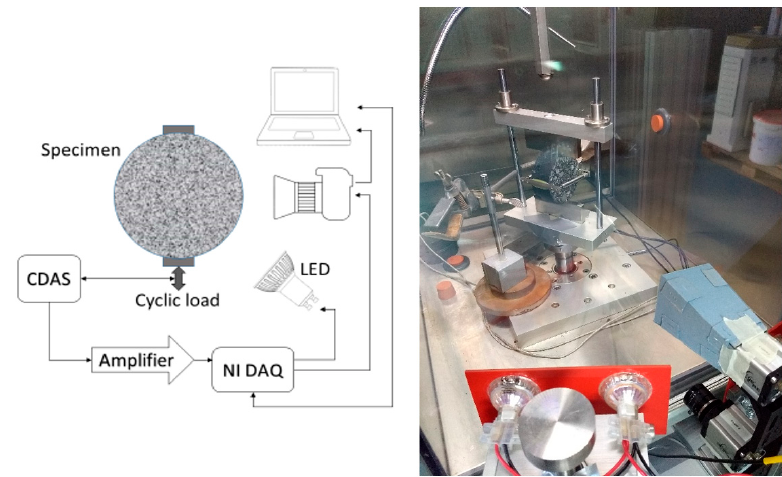
Figure 2. Experimental setup; ( Left ) schematic view of the setup, ( Right ) specimen, camera, and LED spots placed in front of the UTM, only the top camera is active and the whole system is covered with a black plastic cover.